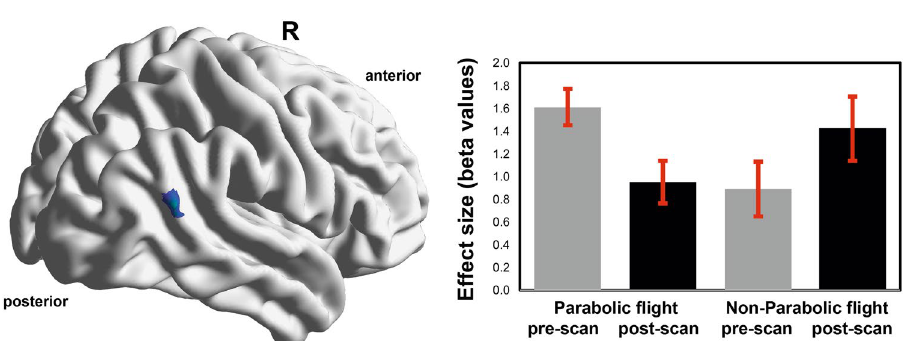
Figure 3. The hypothesis-free exploration of connectivity changes points to the right angular gyrus/temporo- parietal junction as the region with lower scores on the intrinsic connectivity contract, implying that this region has decreased participation in whole-brain connectivity at post-flight scan. The map represents the results of the conjunction analysis, suggesting that the effect can be attributed to the parabolic flight group as compared to the non-parabolic flight control group. Bars indicate effect sizes (beta values) and error bars 90% CI in the same